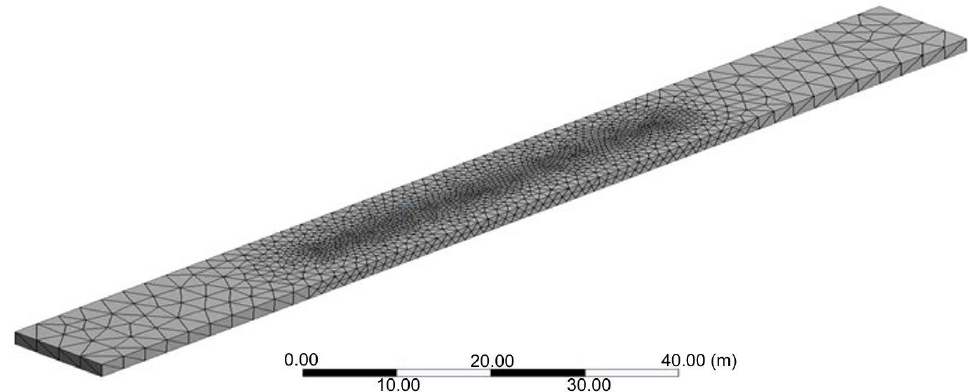
Figure 2. Structural representation of the tetrahedral mesh of the studied broiler house with 13 m in width, 160 m in length.